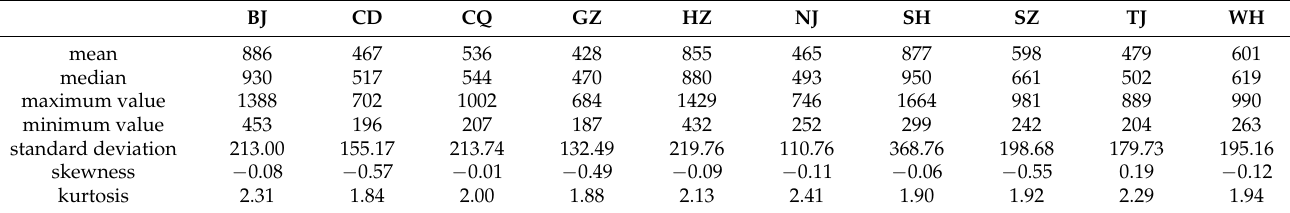
Table 4. Descriptive statistics of information concern index time